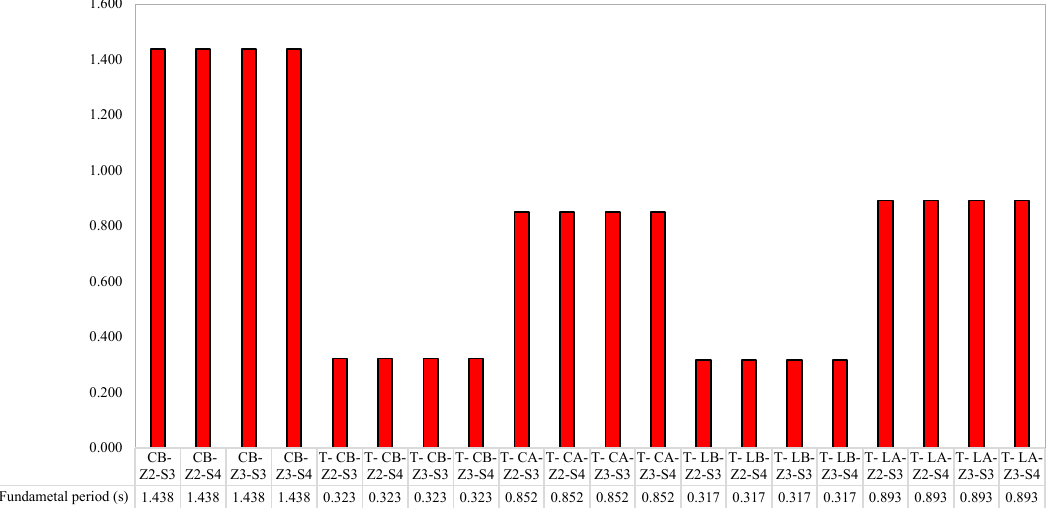
Figure 4. Periods in racks models.